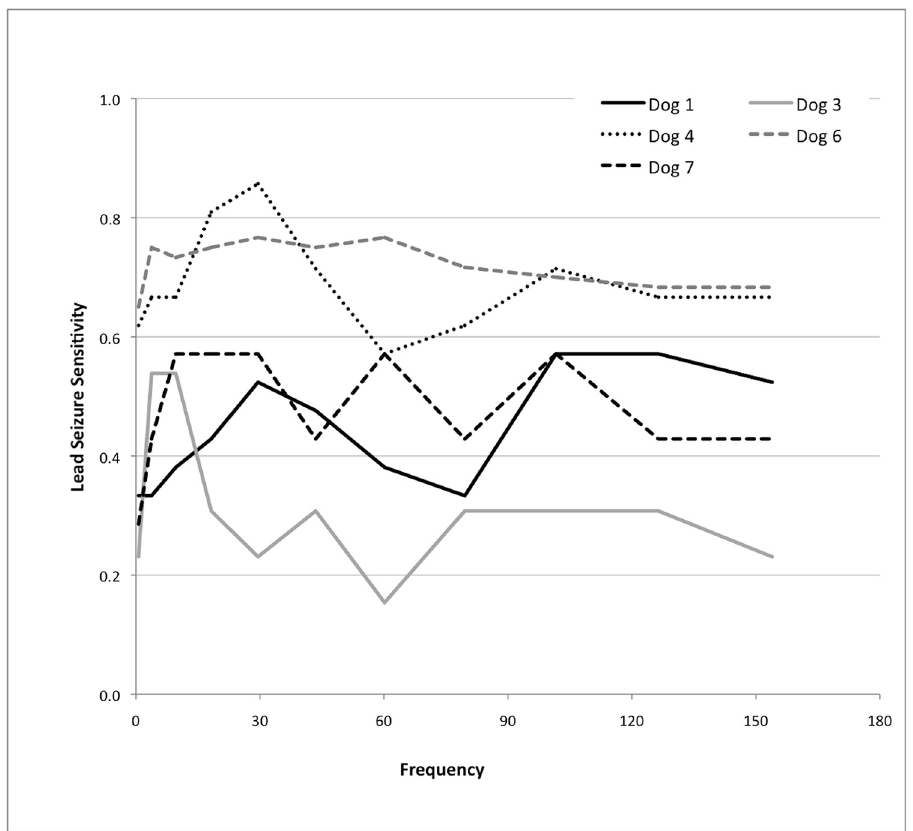
Fig 4. Performance of the SVM-correlation seizure prediction method varies with changes in the frequency band analyzed. The horizontal axis shows the frequency band analyzed in hertz, while the vertical axis shows lead seizure sensitivity for the algorithm, if the algorithm threshold is tuned to maintain time in warning at 30%.